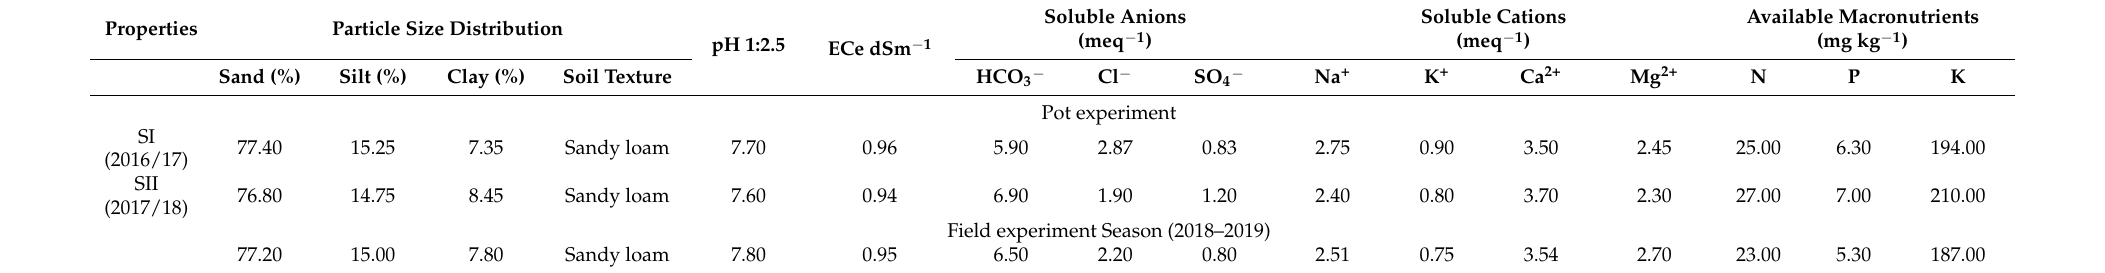
Table 1. Some physico-chemical properties of soil used for the three